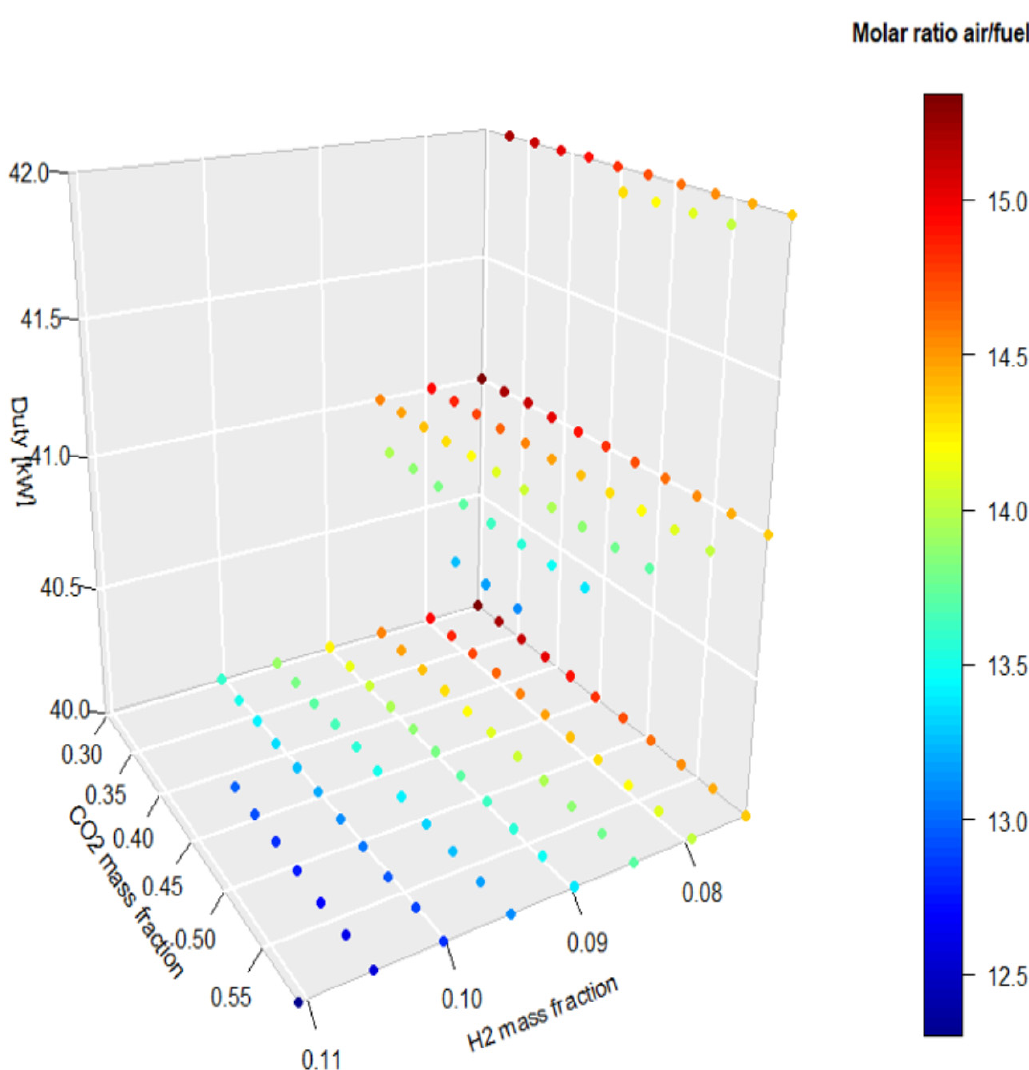
Figure 6. Optimal operation conditions.